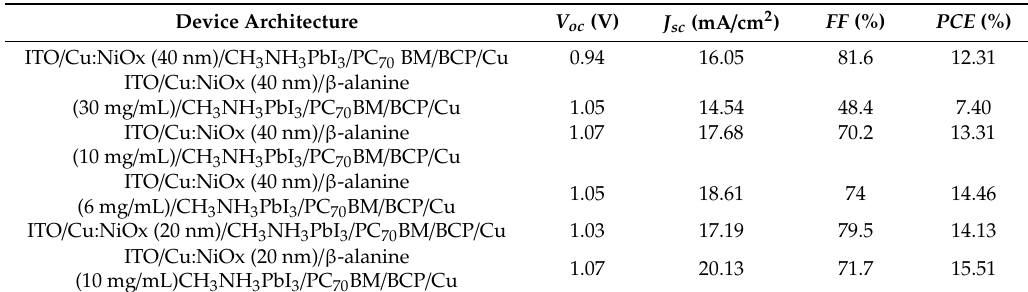
Table 1. Perovskite solar cells (PSCs) photovoltaic (PV) parameters. Device